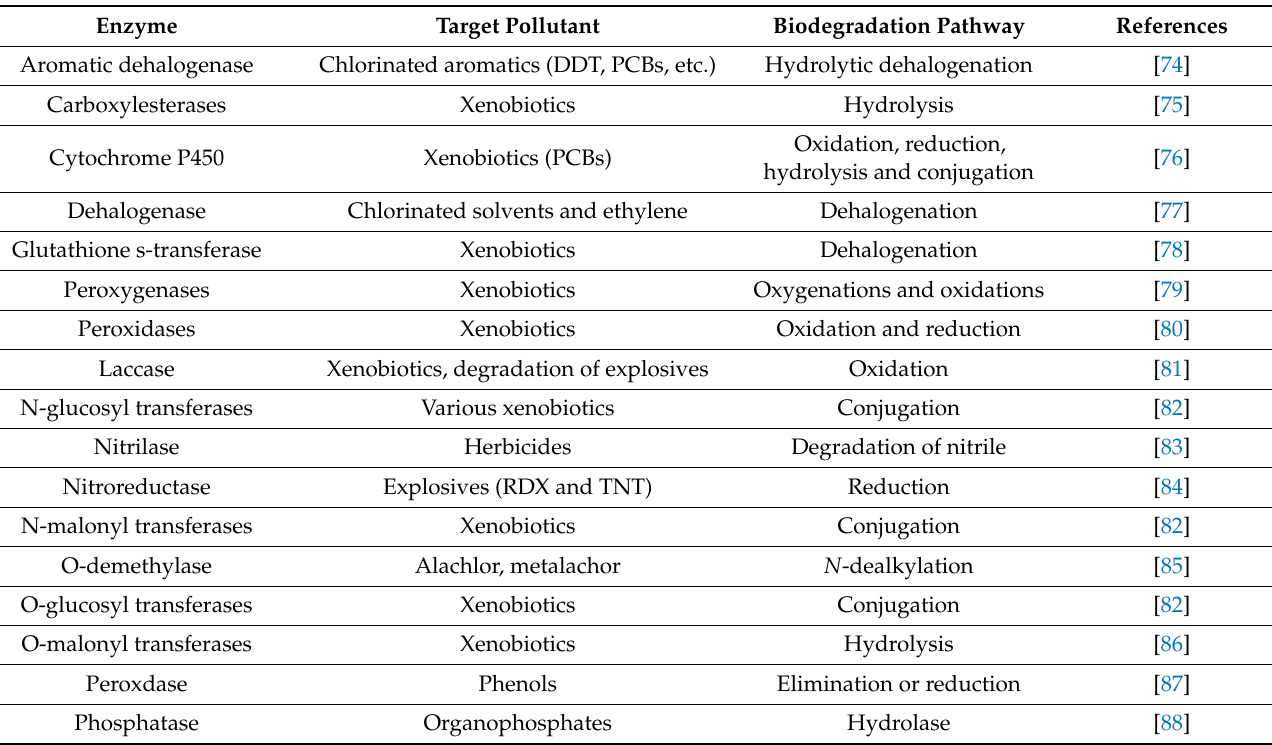
Table 4. Important enzymes associated with the process of rhizodegradation.